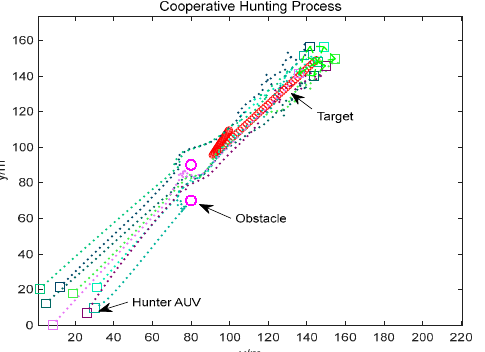
Figure 6. Cooperative hunting process in static obstacle environment based on the APF-based method.